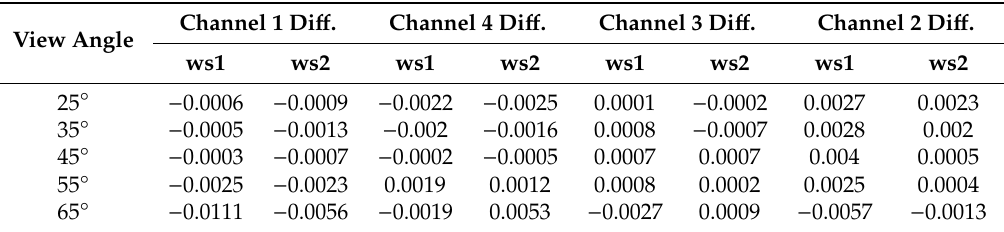
Table 3. The di ff erence between simulated and observed channel emissivities. Channel 1 Di ff . Channel 4 Di ff . Channel 3 Di ff . Channel 2 Di ff . View Angle ws1 ws2 ws1 ws2 ws1 ws2 ws1 ws2 25 ◦ − 0.0006 − 0.0009 − 0.0022 − 0.0025 0.0001 − 0.0002 0.0027 0.0023 0.0008 0.0028 0.002 45 ◦ − 0.0003 − 0.0007 − 0.0002 − 0.0005 0.0007 0.0007 0.004 0.0005 55 ◦ − 0.0025 − 0.0023 0.0019 0.0012 0.0008 0.0002 0.0025 0.0004 65 ◦ −